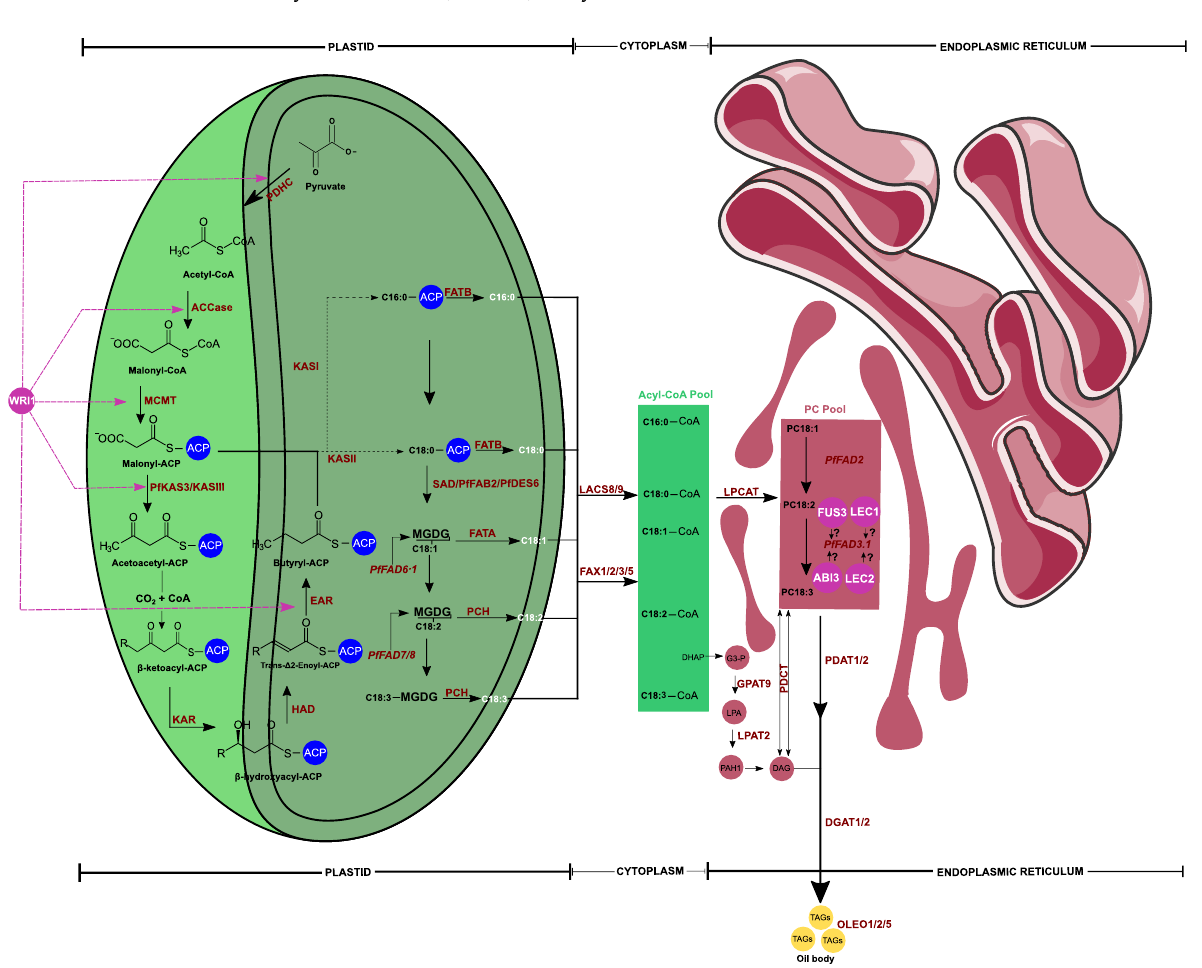
Figure 1. A simplified putative diagram view of fatty acids biosynthetic pathway in Perilla and triacyl- glycerols (TAGs) assembly. The schematic view involved bio-chemical interactions occurring in plas- tid, cytoplasm, and endoplasmic reticulum, respectively. The resulting TAGs are indicated in yellow. Purple circles indicate transcription factors, including WRINKLED ( WRI1 ), FUSCA3 ( FUS3 ), LEAFY COTYLEDON1 ( LEC1 , LCE2 ), and ABSCISIC ACID INSENSITIVE3 ( ABI3 ). The transcriptional regu- lation of FUS3 , LCE1 , LCE2 , and ABI3 with PfFAD3.1 is not yet uncovered. PDHC : plastidial pyruvate dehydrogenase complex; ACCase : acetyl-CoA carboxylase; MCMT : malonyl-CoA ACP transacylase; KASIII : ketoacyl-ACP synthase type III; KAR : 3-ketoacyl-ACP reductase; HAD : 3-hydroxyacyl-ACP dyhydratase; EAR : 2-enoyl-ACP reductase; KASII : ketoacyl-ACP synthase type II; KASI : ketoacyl- ACP synthase type I; SAD : stearoyl-acyl carrier protein desaturase; FATB : acyl-ACP thioesterase B; FATA : acyl-ACP thioesterase A; MGDG: monogalactosyldiacylglycerol; PfFAD : Perilla frutescens fatty acid desaturase; PC Pool: phosphatidylcholines pool; PCH : palmitoyl-CoA hydrolase; LACS : long- chain acyl-CoA synthetase; PDCT : phosphatidylcholinediacylglycerol cholinephosphotransferase; FAX : fatty acid export; LPCAT : lysophosphatidylcholine acyltransferase; PDAT : phospholipid dia- cylglycerol acyltransferase; DGAT : diacylglycerolacyltransferase; GPAT : glycerol-3-phosphate acyl- transferase; LPAT : 1-acylglycerol-3-phosphate acyltransferase; DHAP : dihydroxyacetone phosphate; PAH : phosphatidic acid phosphatase; OLEO :